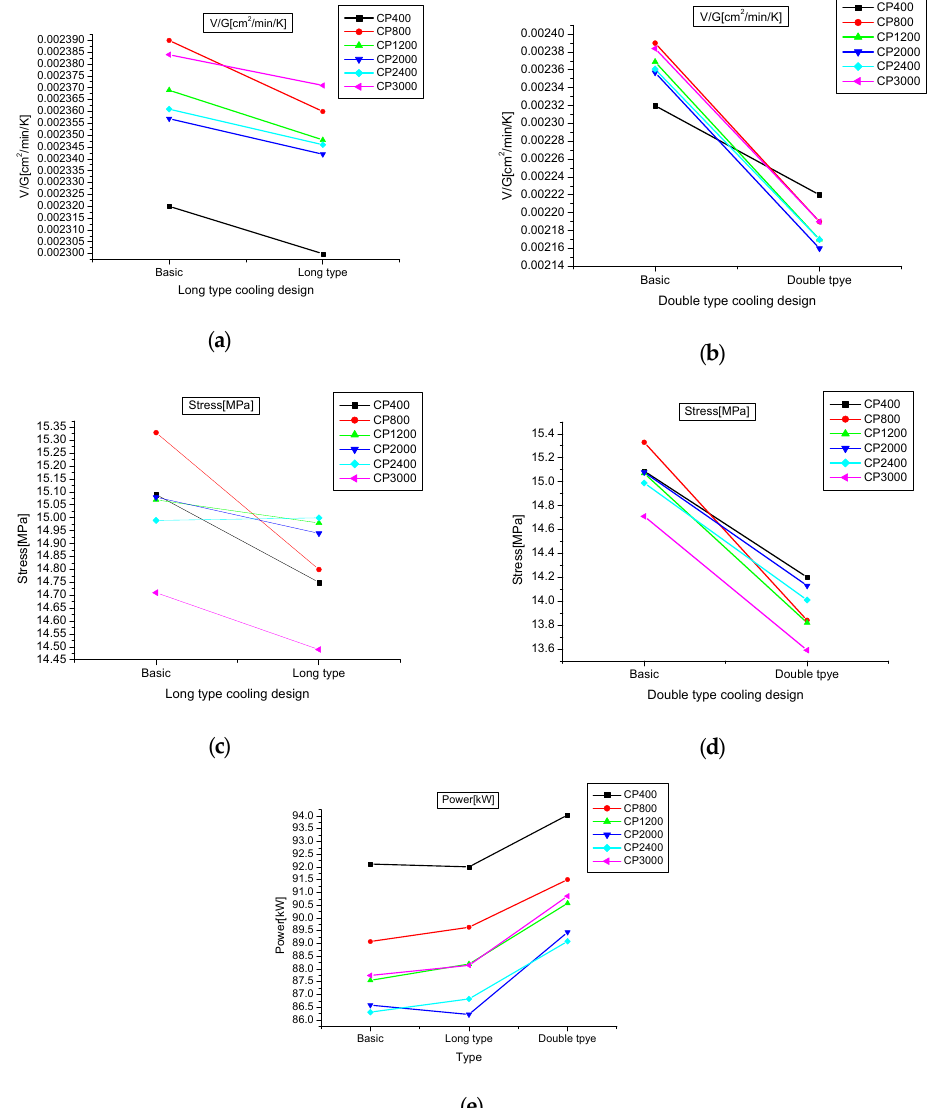
Figure 7. Comparative analysis of the BTCD, LTCD, and DTCD ( a ) and ( b ) V/G results; ( c ) and ( d ) von Mises stress; and ( e ) the power.